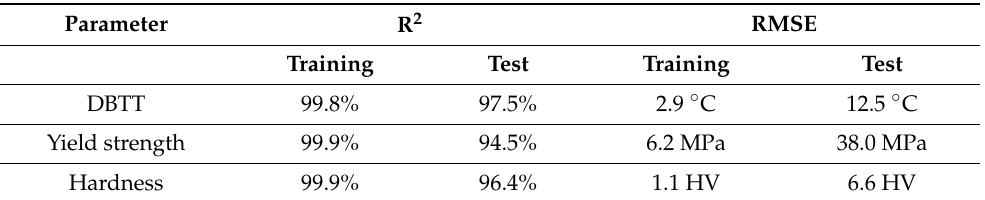
Table 5. Correlation coefficients (R 2 ) and root mean square errors (RMSEs) for the estimation of DBTT, mechanical hardness, and yield strength of A508 Cl.2 material.